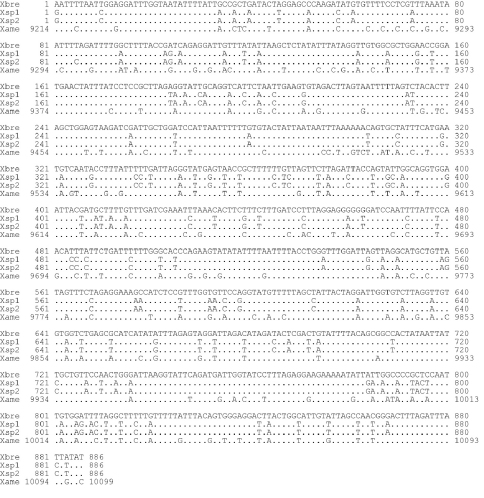
Sequence comparison of mitochondrial COI region. Xbre: X. brevicolle (this study: GenBank accession AB604337); Xsp1, Xsp2: Xiphinema sp. (this study: AB604338 and AB604339 respectively); Xame: X. americanum (He et al. 2005: usAY382608).